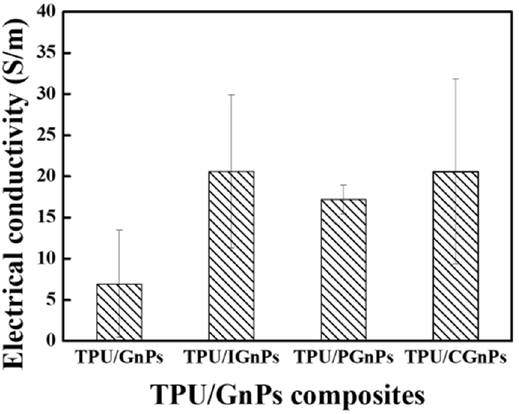
Figure 4. Electrical conductivity of various TPU/GnPs composites.